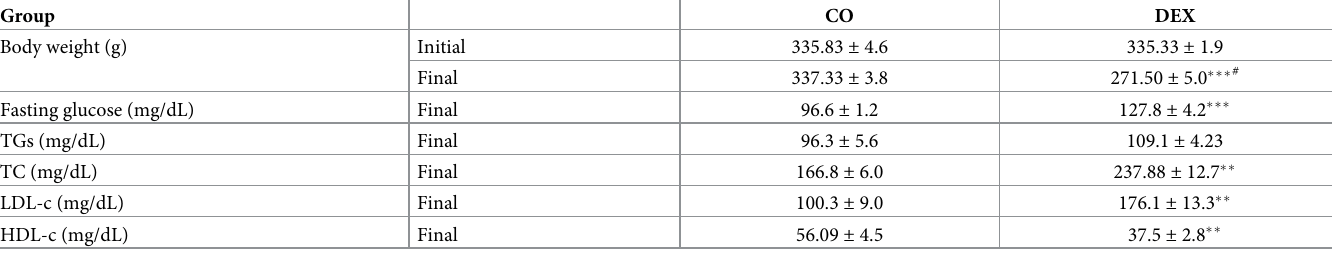
CO, Control group; Insulin resistance (DEX) group. All of the values are the mean ± S.E.M., (n = 6). For data analysis, one-way ANOVA was used followed by Bonferroni post-test for the bodyweight and Student’s unpaired t-test was used for the fasting glucose, triglycerides (TG), total cholesterol (TC), low-density lipoprotein cholesterol (LDL-c) and high-density lipoprotein cholesterol (HDL-c). �� p < 0.01 and ��� p < 0.001 vs . CO